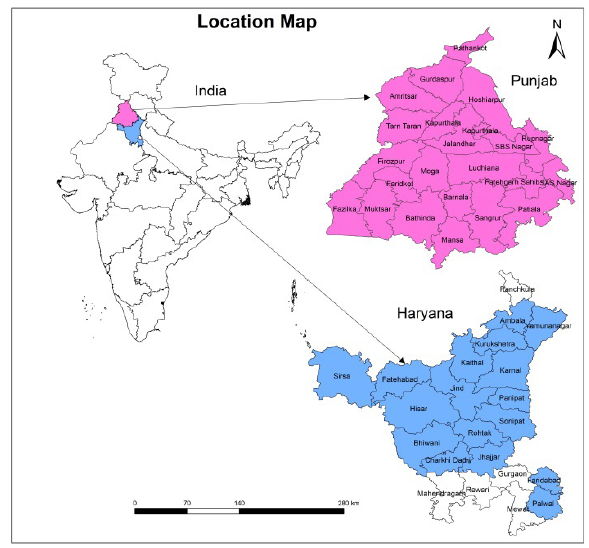
Figure1. Study area map.